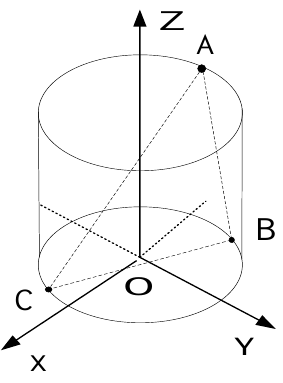
Figure 9. The model of antenna